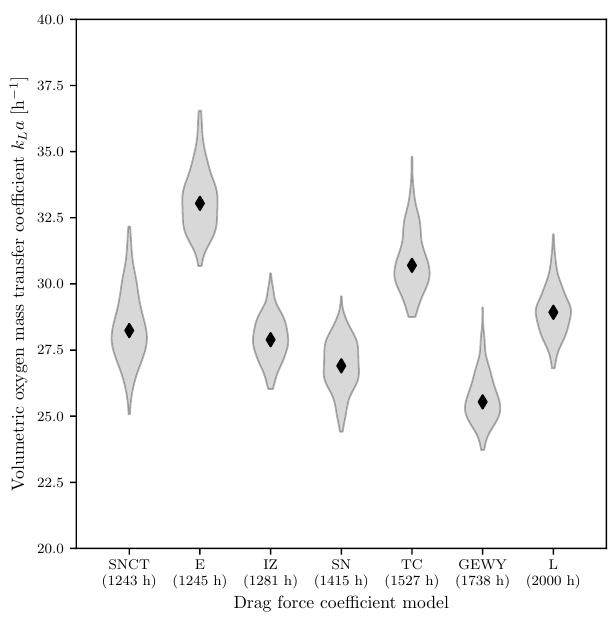
Figure 5. Influence of the drag force coefficient model on the k L a value. The mean values and the corresponding probability density function are shown in violin form. The time corresponds to the CPU time for the simulation of 20 s (SNCT = Schiller and Naumann [76] with swarm correc- tion, E = Ergun [77], IZ = Ishii and Zuber [78], SN = Schiller and Naumann [76], TC = Tomiyama correlated [79], GEWY = Gidaspow, Ergun, Wen, and Yu [80], L = Lain